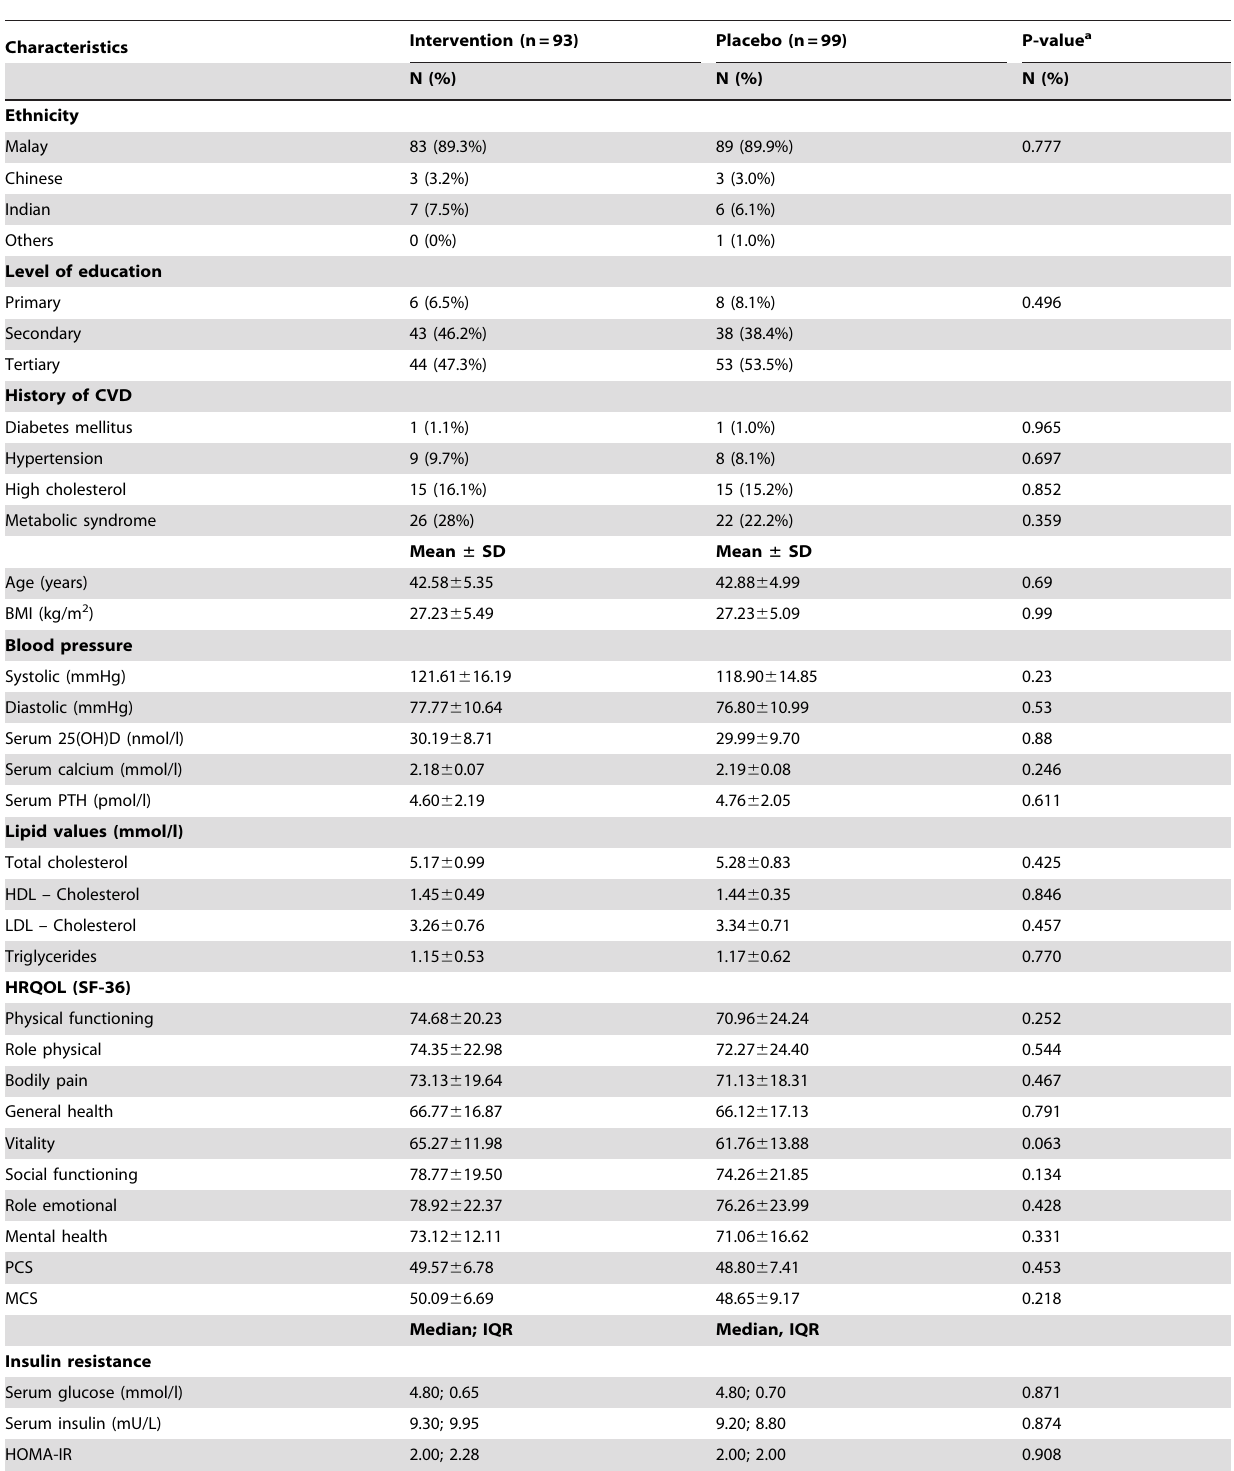
Table 1. Baseline socio-demographic characteristics of the intervention and placebo groups.